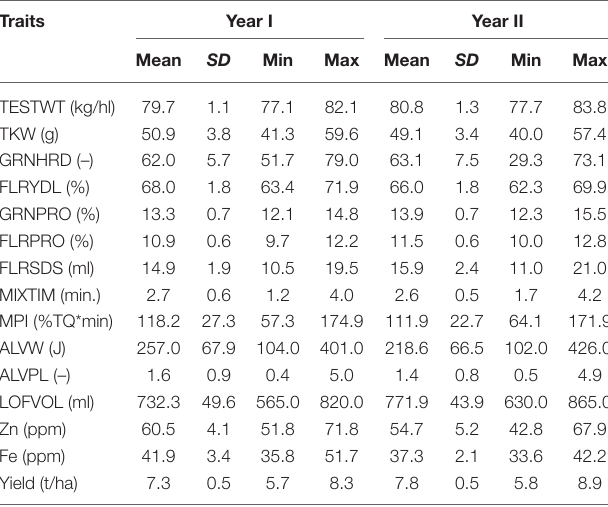
Frontiers in Sustainable Food Systems |